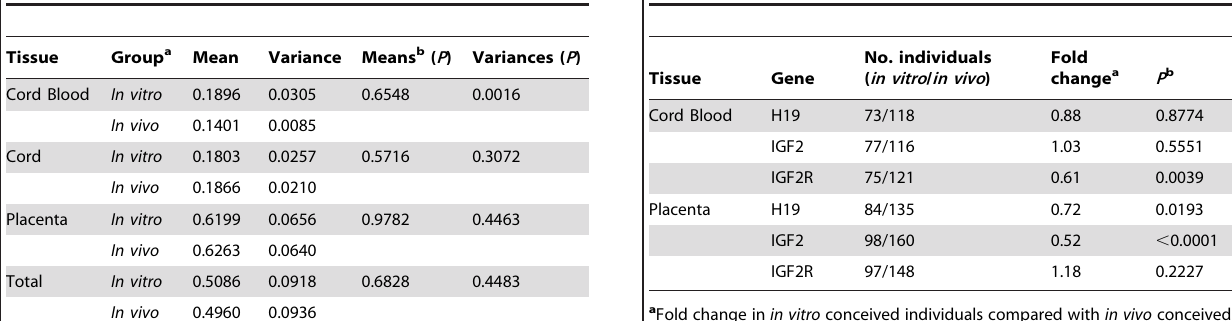
Table 4. Intra- and inter-individual variation in DNA methylation at the IGF2R DMR.